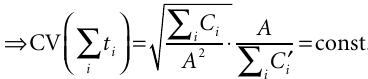
= 1, t = 0.5, t = 0.25, t = 0.125. Below threshold, these activations are 1 2 3 4